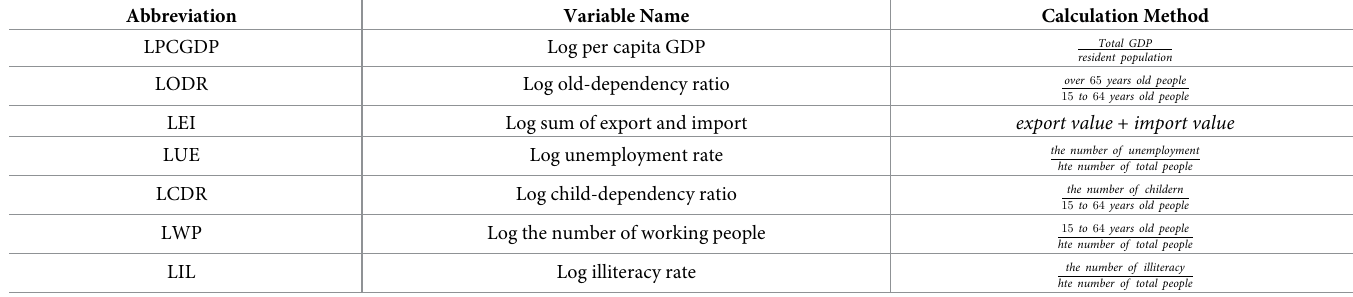
Table 1. Definition of research